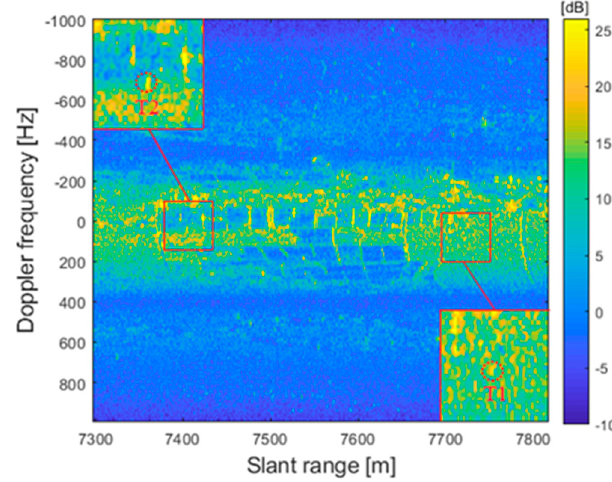
Figure 7. Range − Doppler image before clutter suppression.